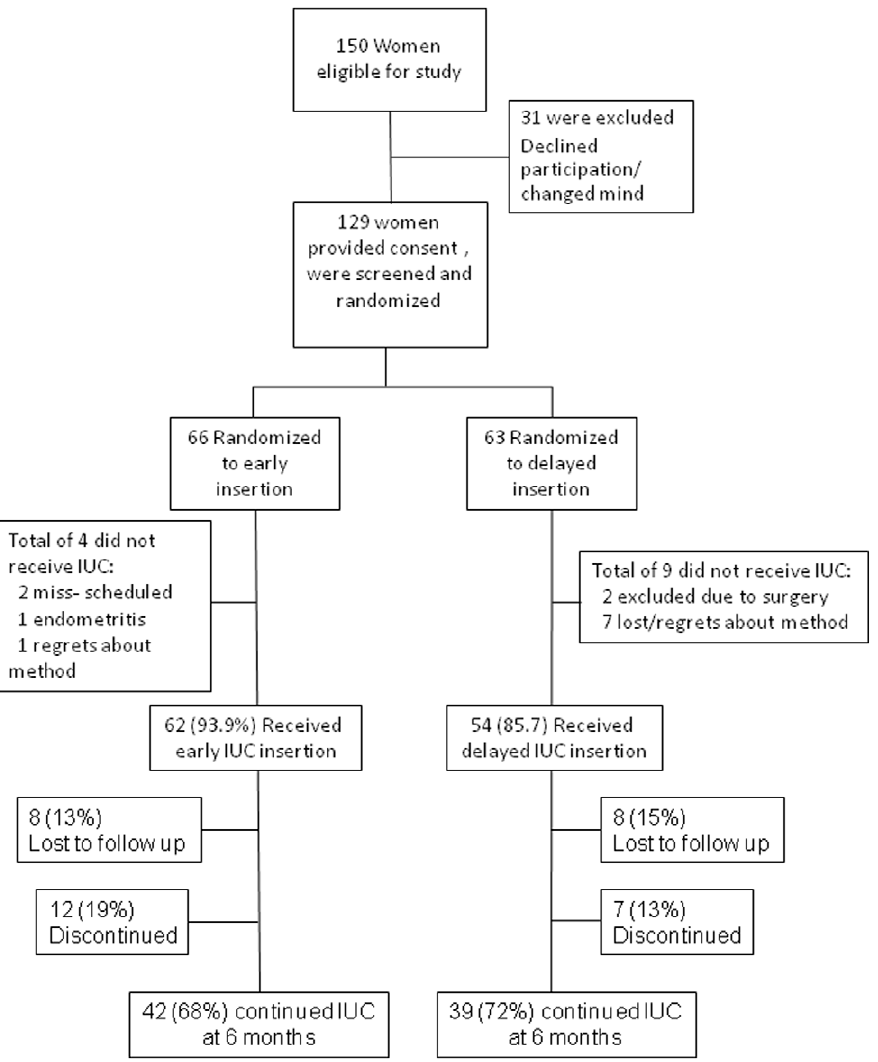
Figure 1. Study flow chart. Randomization and follow up of Study Participants. Women who missed an evaluation could return for later follow-up visits.